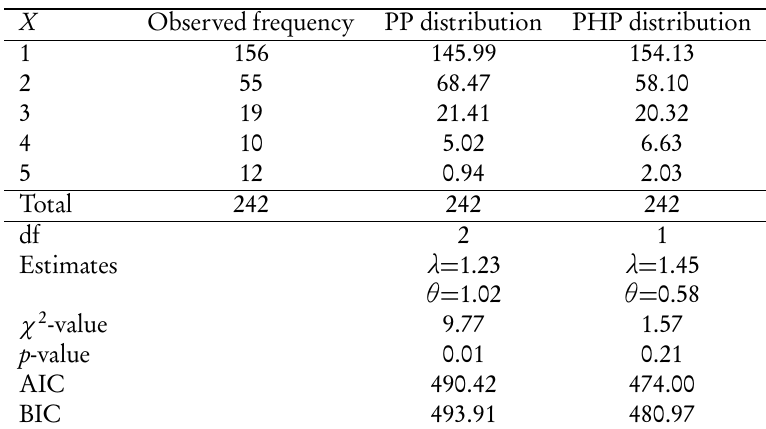
Distribution of family of epidemics of common cold obtained by Heasman and Reid (1961) and the expected frequencies computed using the positive Poisson and the PHP